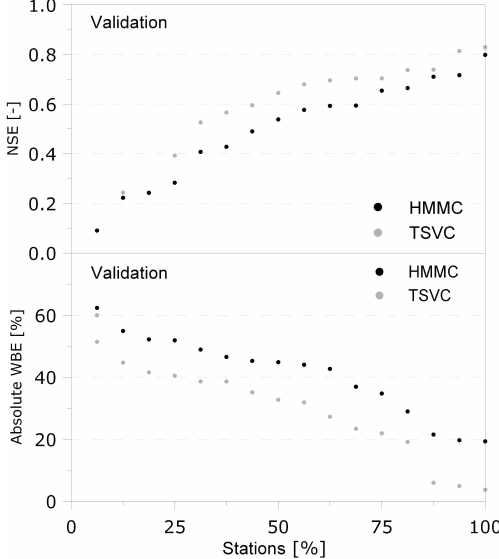
Fig. 12. Sorted model performance for absolute WBE summer for both models during calibration and validation.